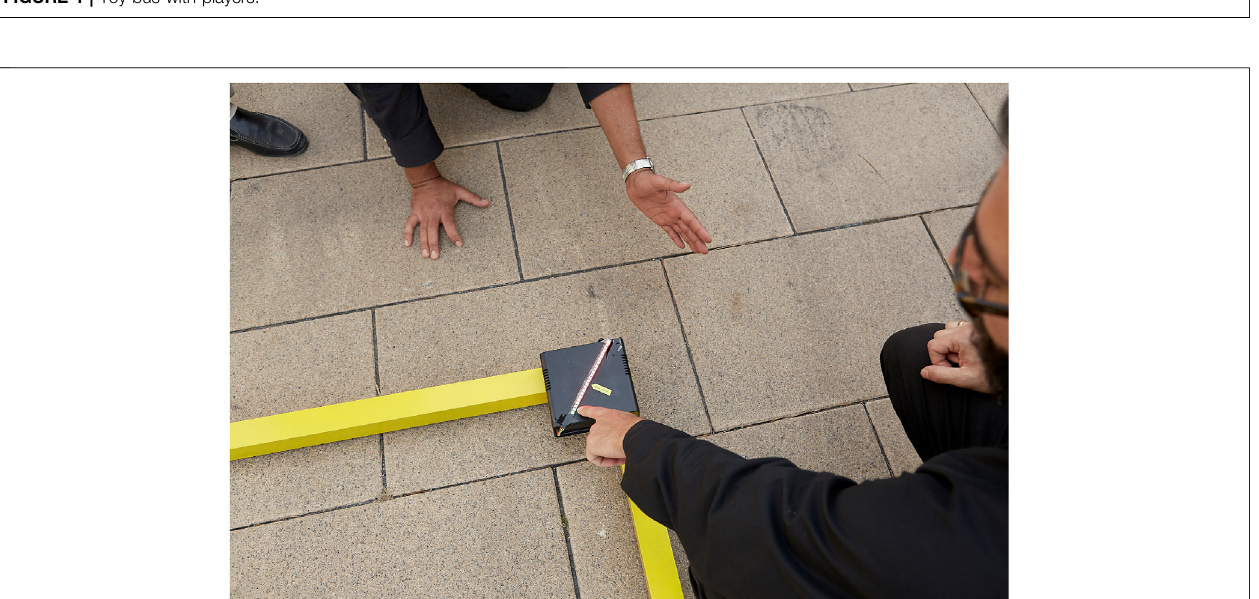
FIGURE 2 | Proximity sensor with